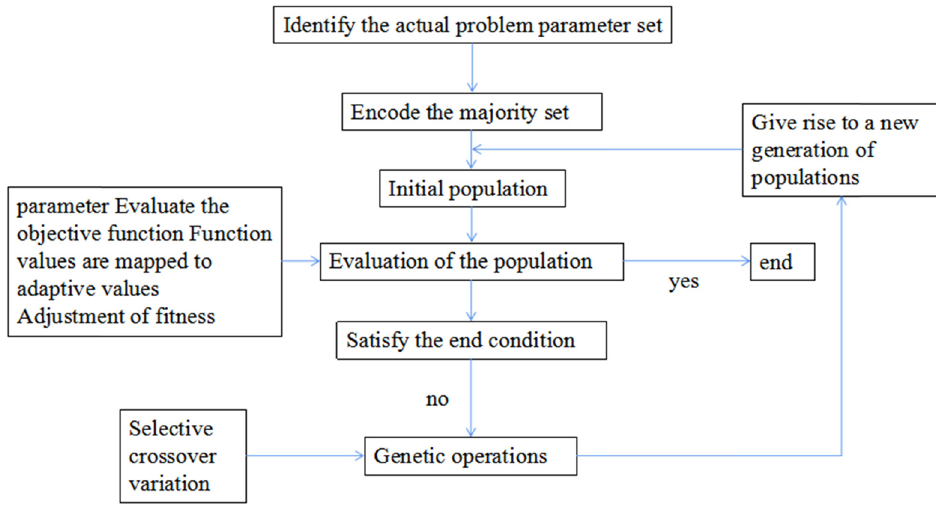
Figure 2: Flow chart of genetic algorithm optimization process.